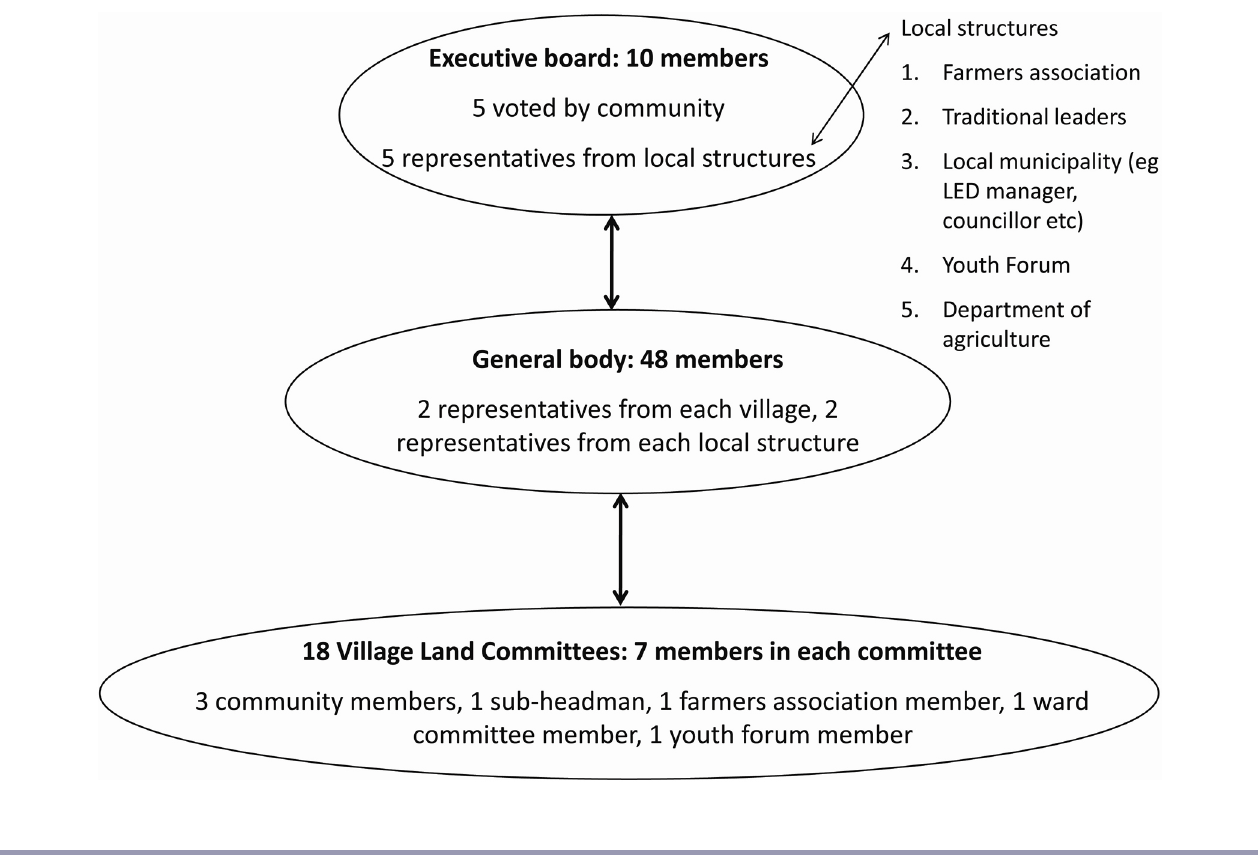
Fig. 1 . The Machubeni Section 21